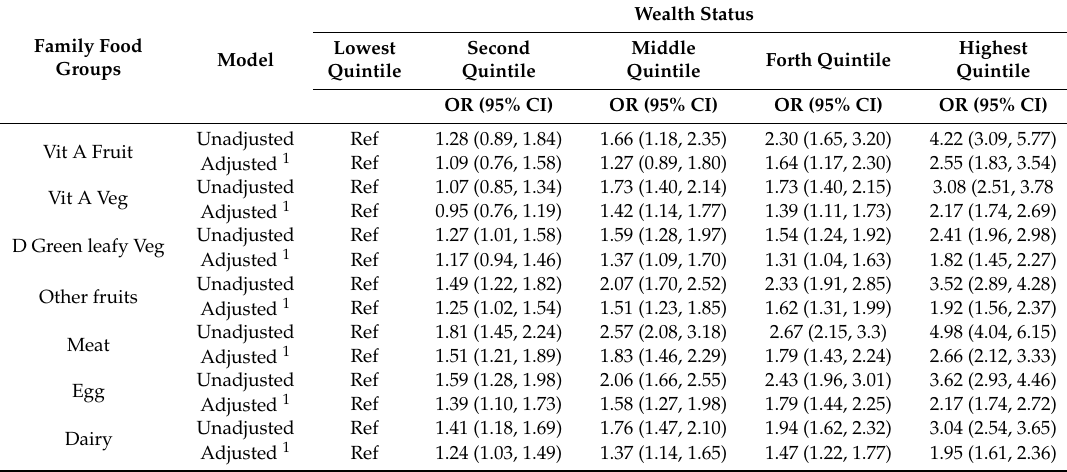
Table 5. Family food consumption and its association with household wealth, Addis Ababa, Ethiopia.